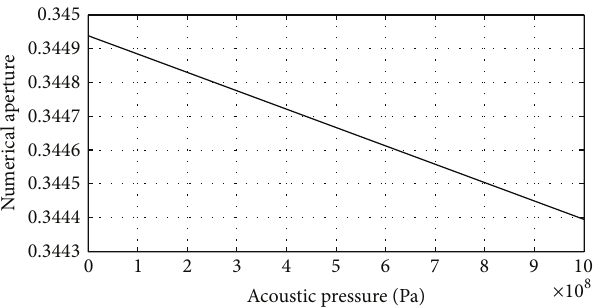
Figure 8: The calculated NA of the investigated HC-PBF as a function of the acoustic pressure at acoustic frequency 10